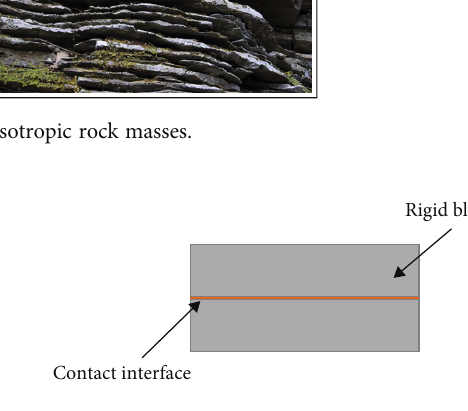
Figure 2: Standard rigid block model